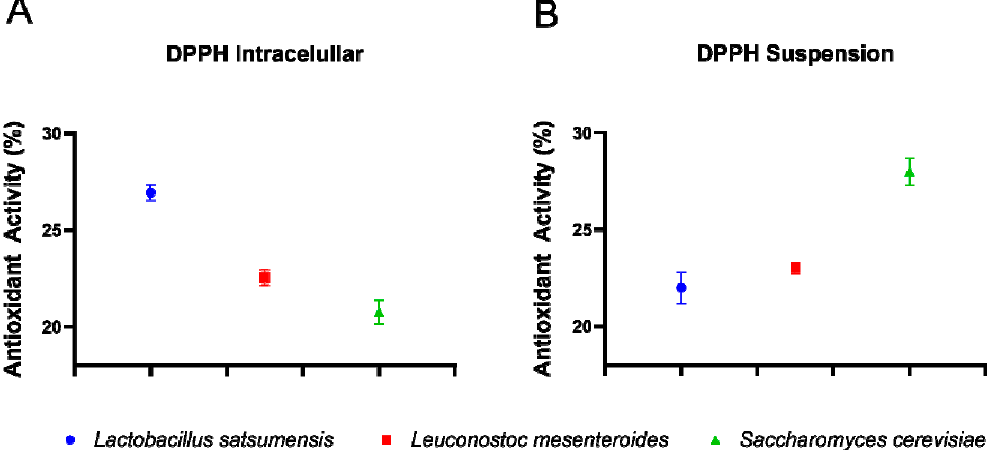
Figure 5. Antioxidant activity of intracellular ( A ) and extracellular ( B ) cells of Lactobacillus satsumensis LPBF1, Leuconostoc mesenteroides LPBF2 and Saccharomyes cerevisiae LPBF3.